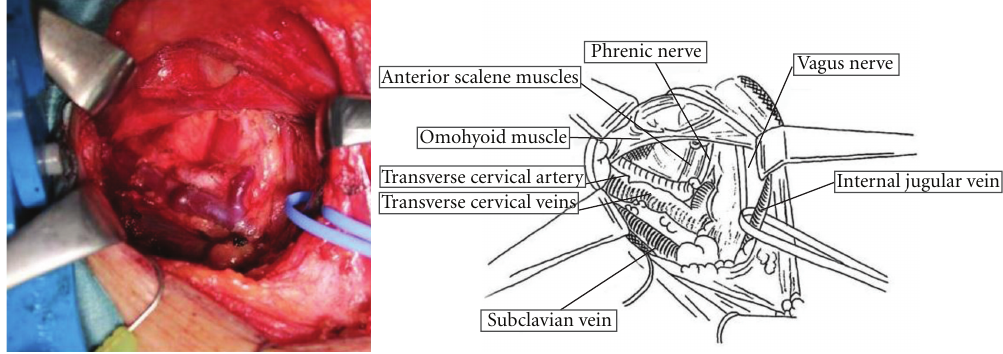
Figure 3: Dissection of the right side supraclavicular lymph